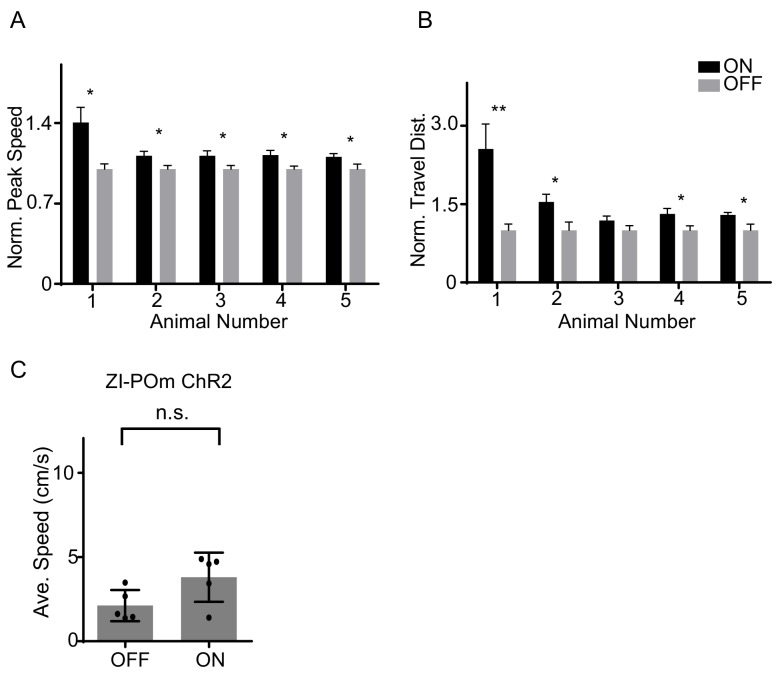
Analysis of individual animals and control experiment of LED stimulation alone.(A) Normalized peak speed for each animal without (gray) and with (black) blue LED light stimulation. *p<0.05, two-sided unpaired t-test. Error bars represent mean ± s.e.m. (B), Normalized total travel distance for each animal without (gray) and with (black) blue LED light stimulation. **p<0.01, *p<0.05, two-sided unpaired t-test. Error bars represent mean ± s.e.m. (C), Summary of average locomotion speed without and with LED light stimulation alone. ‘n.s.”, non-significant, two-sided paired t-test, n = 5 animals. Error bars represent mean ± s.d. Supplementary and source data files.